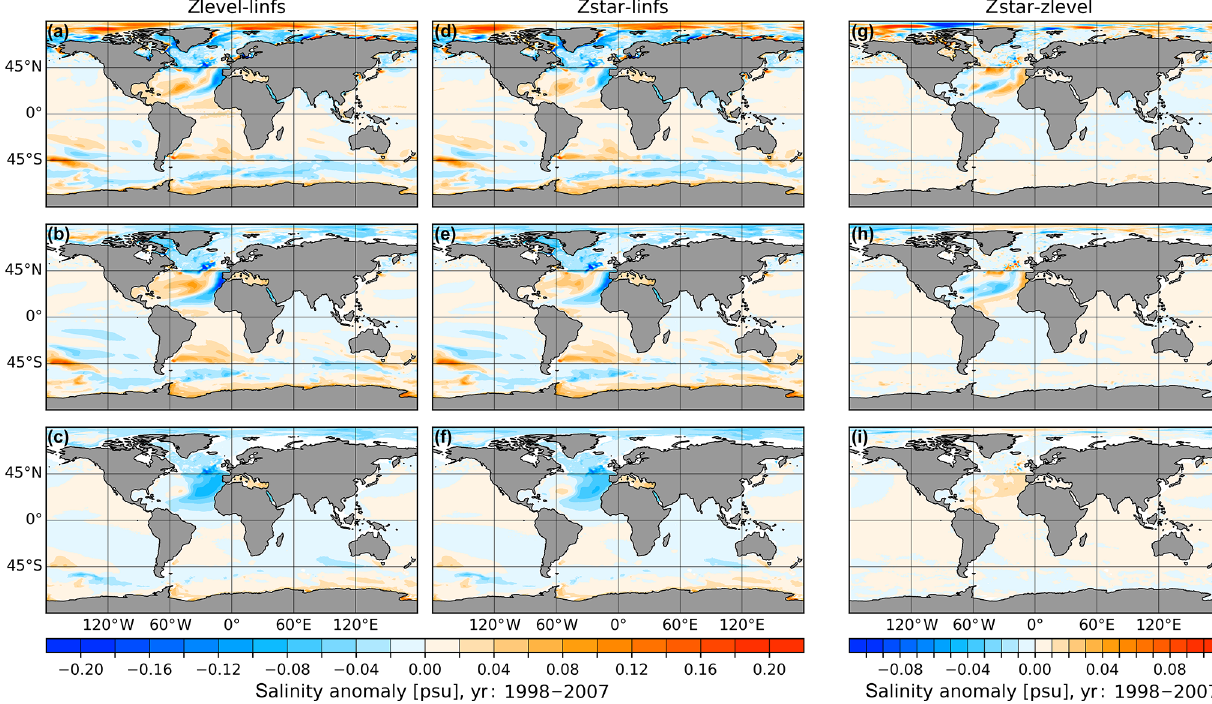
Figure 3. Same as Fig. 2 but for